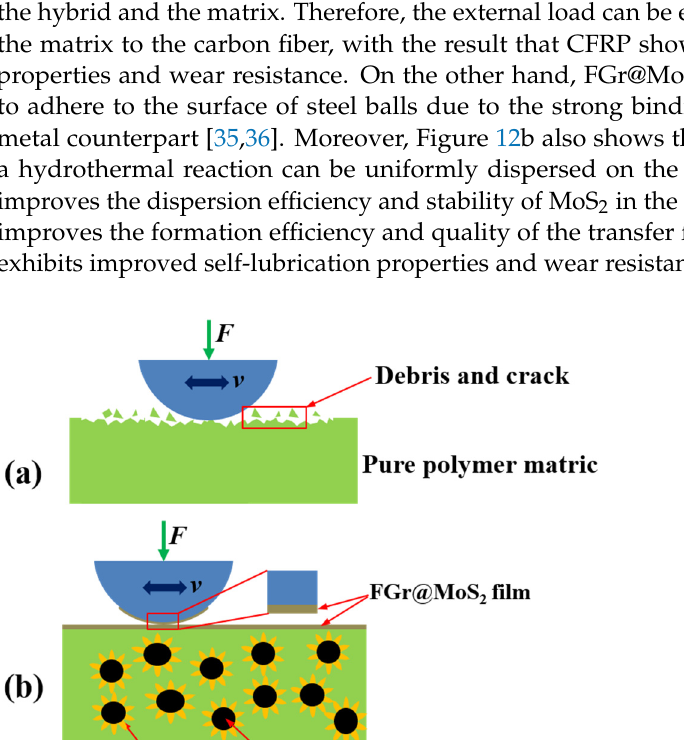
Figure 11. Optical images of worn surface of FGr@MoS 2 -1.2 at ( a ) 23 °C, ( b ) 40 °C, and ( c ) 60 °C; counterpart ball at ( d ) 23 °C, ( e ) 40 °C, and ( f ) 60 °C.